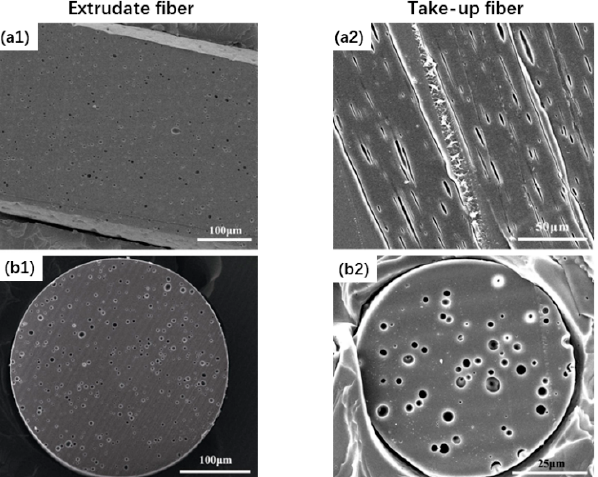
Figure 4. SEM micrographs of polypropylene (PP)/polystyrene (PS) extrudate fiber and blend fiber taken at 500 m/min from ( a1 and a2 ) a longitudinal section and ( b1 and b2 ) a cross section after removing the dispersed PS phased in solvent. The dark spots on the cross section represent PS phases. The weight percent of PS phase in blend fiber is 8%; the zero-shear viscosity ratio of PS/PP is 10.8 [31]. Reproduced with permission from He, H.; Chen, L.; Zhang, Y.; Hong, S.; Zhou, Y.; Zhu, M., Fibers and Polymers; published by Springer Nature, 2014.